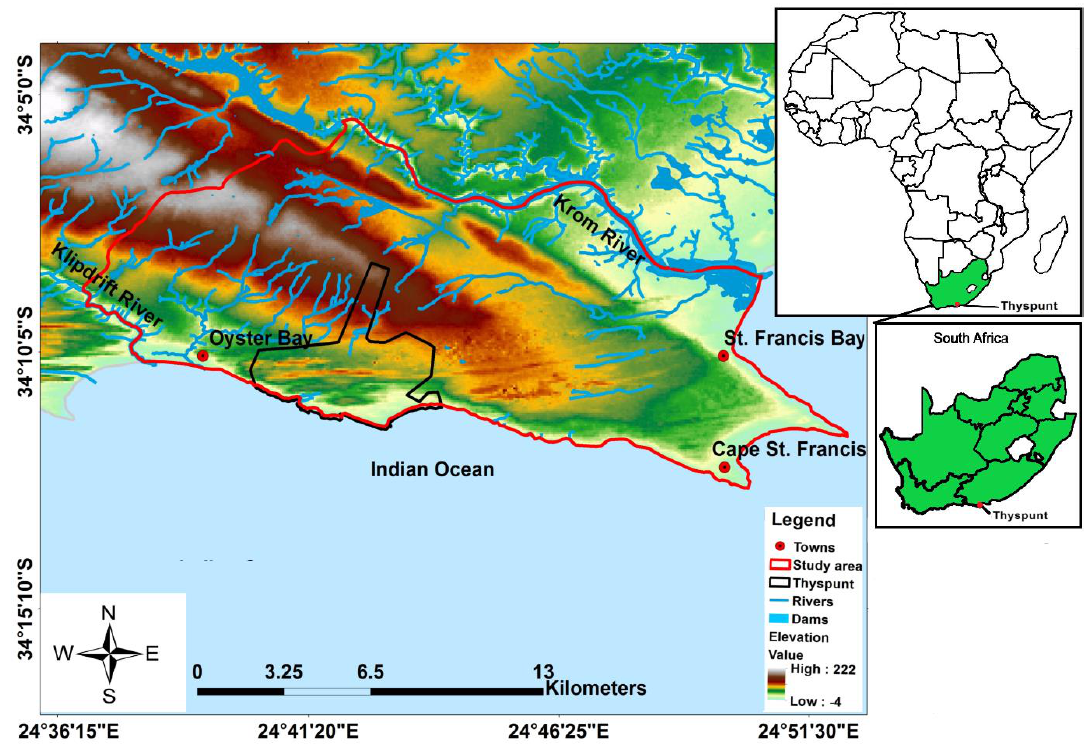
Figure 1. Location map of the study area, including topographic elevation in m.a.s.l..